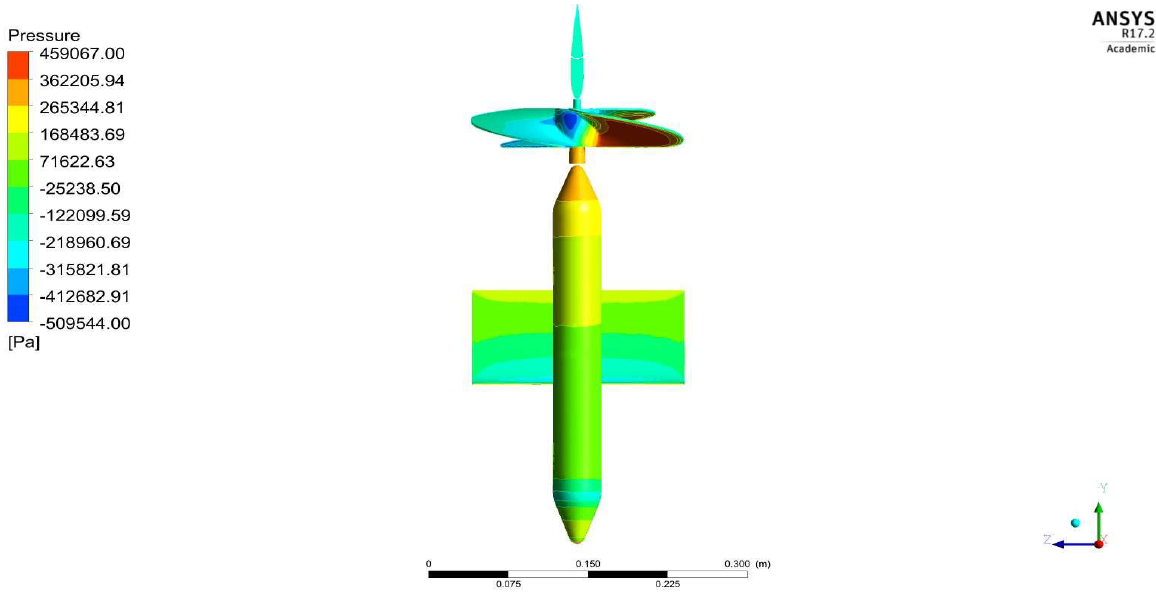
Figure 35. A top view based projection of pressure distributions on advanced US with horizontal fins—high speed altitude increment operation.